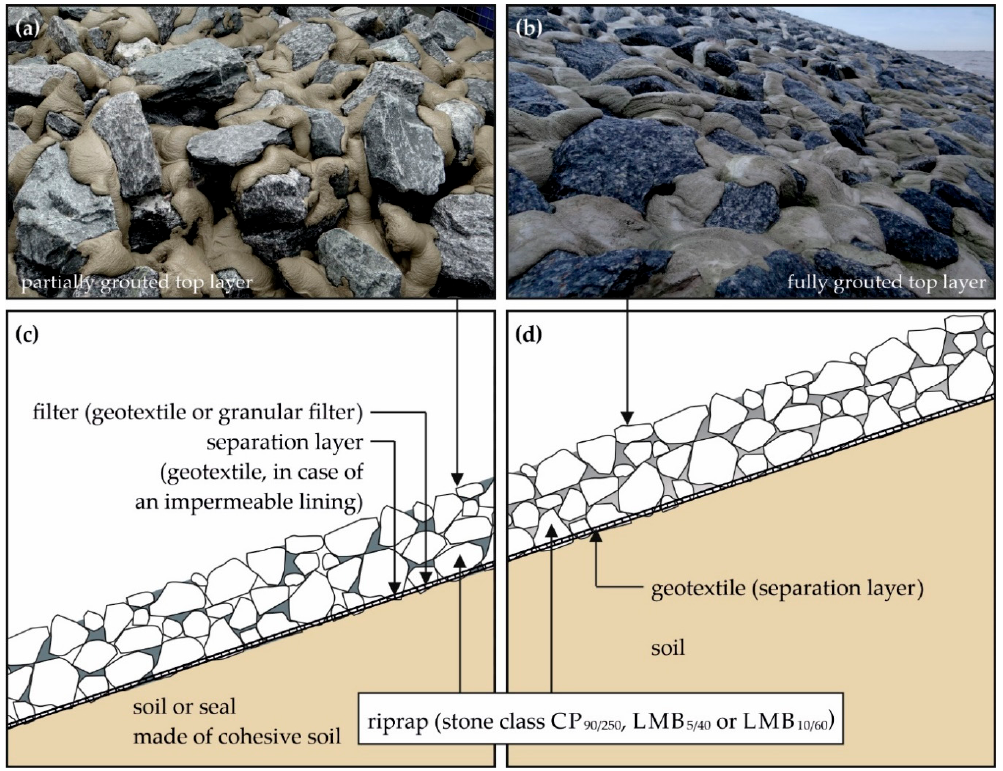
Figure 1. View of ( a ) a partially grouted top layer and ( b ) a fully grouted top layer (Photos: Figure1. Viewof( a )apartiallygroutedtoplayerand( b )afullygroutedtoplayer(Photos: Kreyenschulte, Kreyenschulte, 2015) as well as schematic representations of the cross ‐ section of ( c ) partially grouted 2015) as well as schematic representations of the cross-section of ( c ) partially grouted MGRRs and MGRRs and ( d ) fully grouted MGRRs (modified after [4]). ( d ) fully grouted MGRRs (modified after